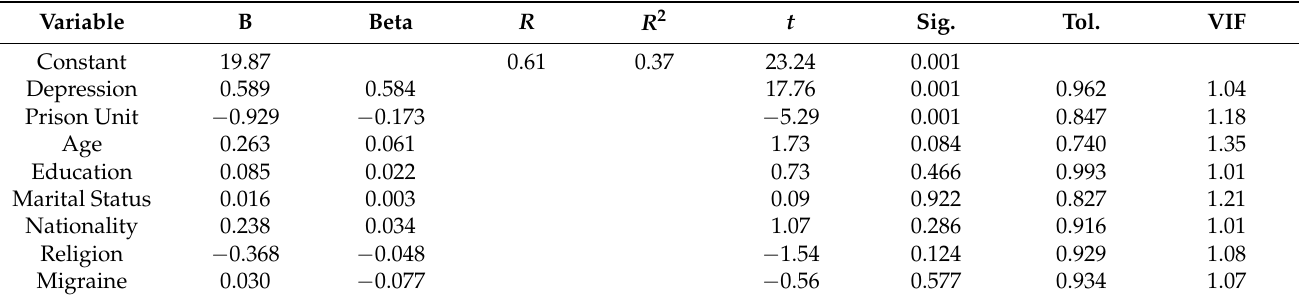
Table 3. Effects of depression, migraine, prison unit, demographics of inmates on their stress